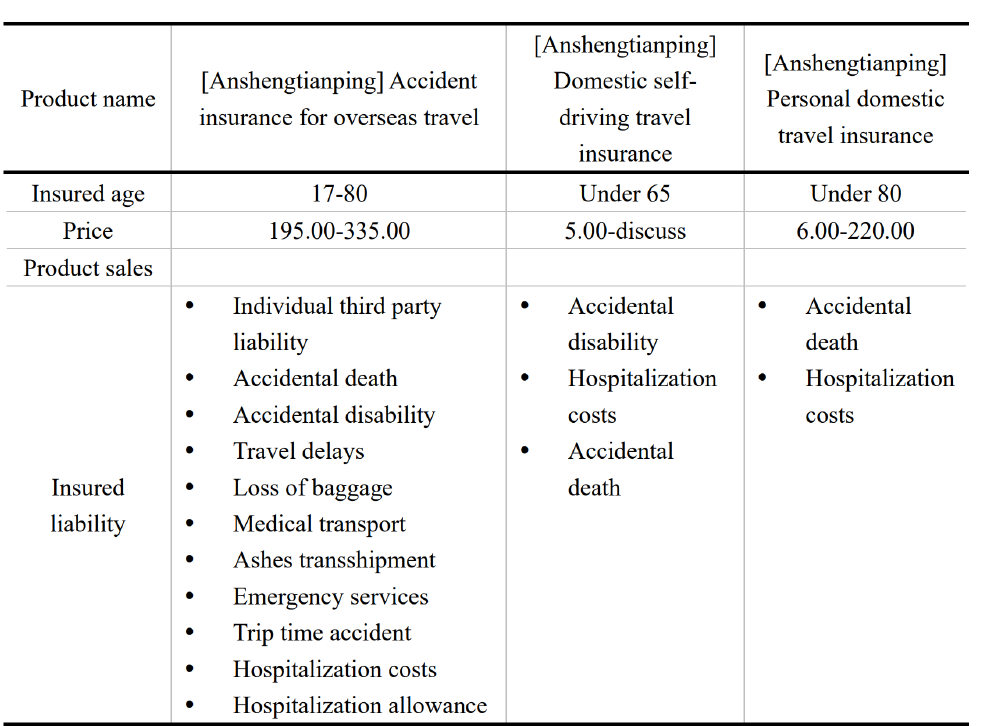
Figure 4. Structured documents output. Document information is extracted for structured compar- ison. (The language of insurance documents is Chinese. We translate the structured output into English for better understanding. See the appendix file Figure A3 for the Chinese